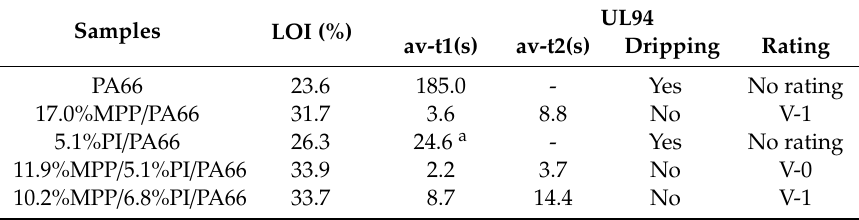
Table 2. The LOI value and UL94 rating of flame-retardant PA66.